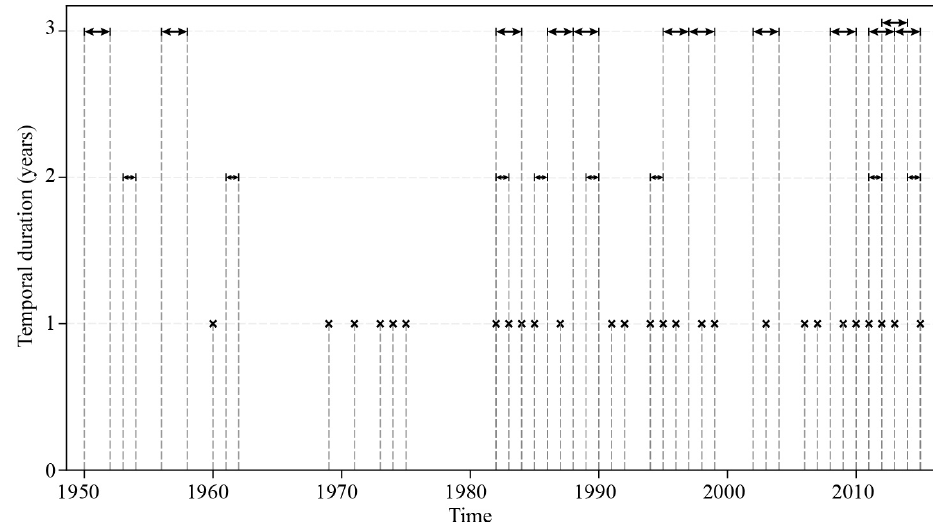
Figure 6. Temporal duration of flash flood disaster clusters detected via the “yearly model” ( R max = 200km, T agg = 1 year, T max = 3 years).